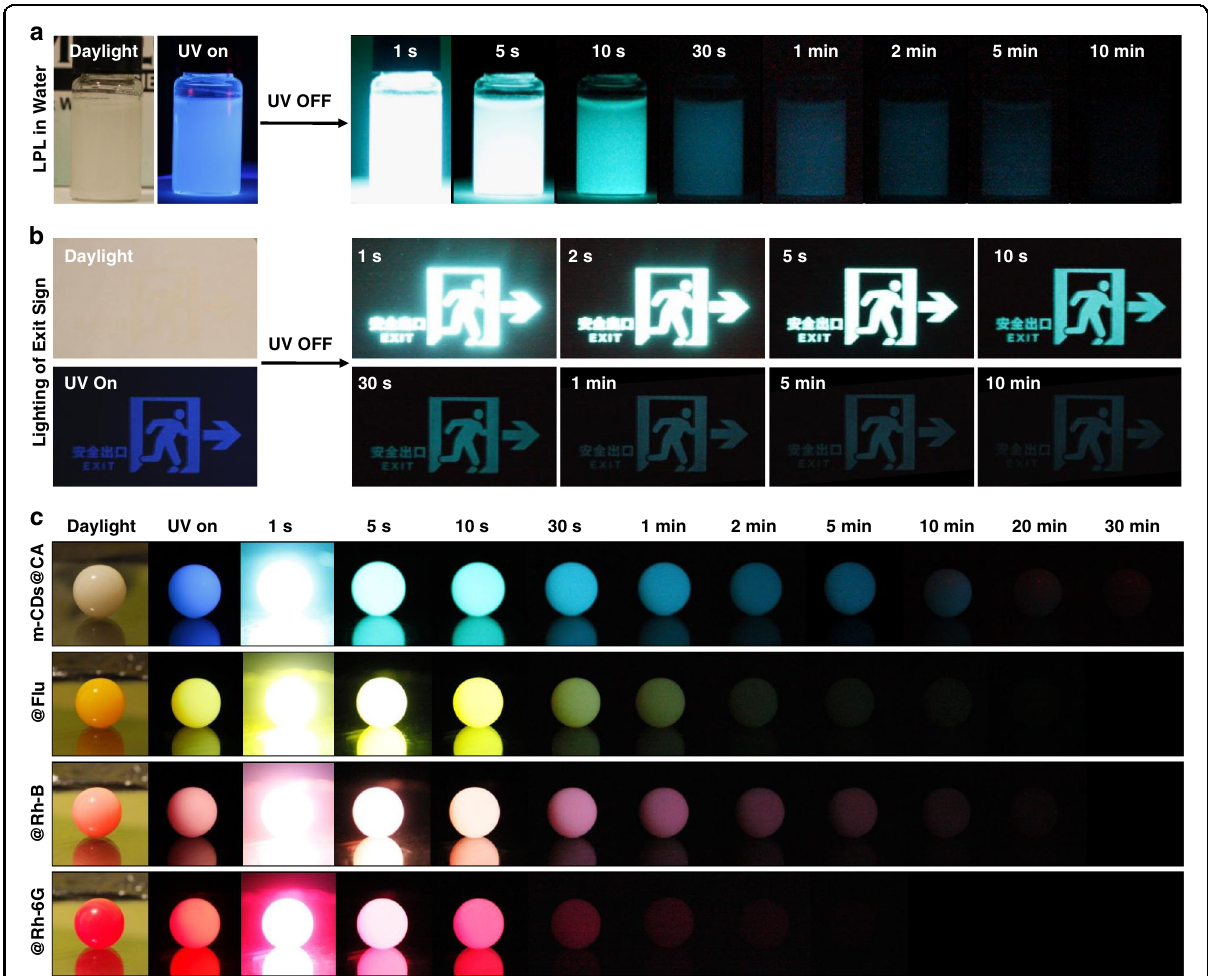
Fig. 6 The robust LPL property of m-CDs@CA and its possible applications. a Photographs of the aqueous m-CDs@CA dispersion in daylight, under UV lamp (365 nm) and after the UV lamp was turned off after 1 min irradiation. b Images of an emergency sign after UV irradiation was stopped; the sign was created using an m-CDs@CA suspension patterned on fi lter paper by silk-screen printing. c Photographs of luminous pearls prepared using m-CDs@CA with and without added fl uorescent dyes (dispersed in epoxy resin) under daylight, a UV lamp (365 nm) and switching off the UV lamp after 1 min of